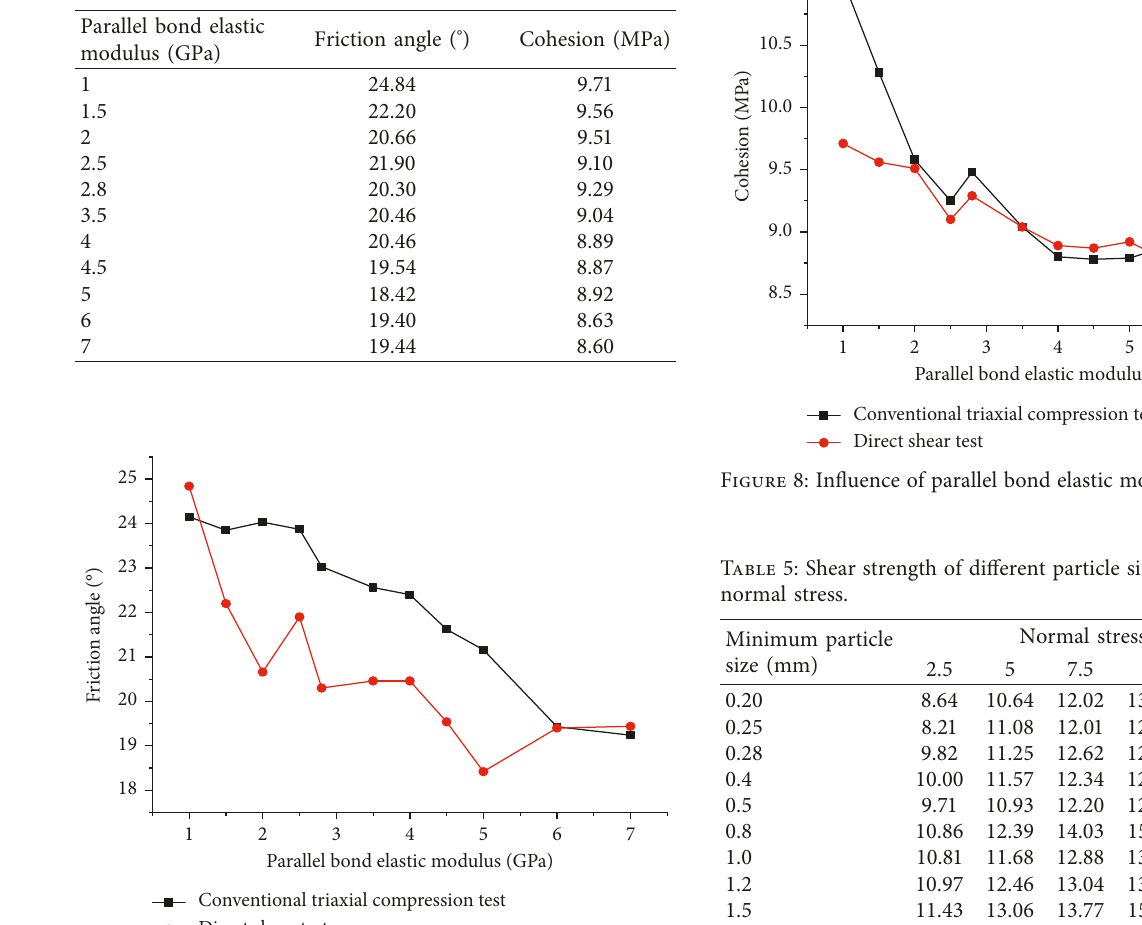
Table 4: Shear strength parameters of different parallel bond elastic